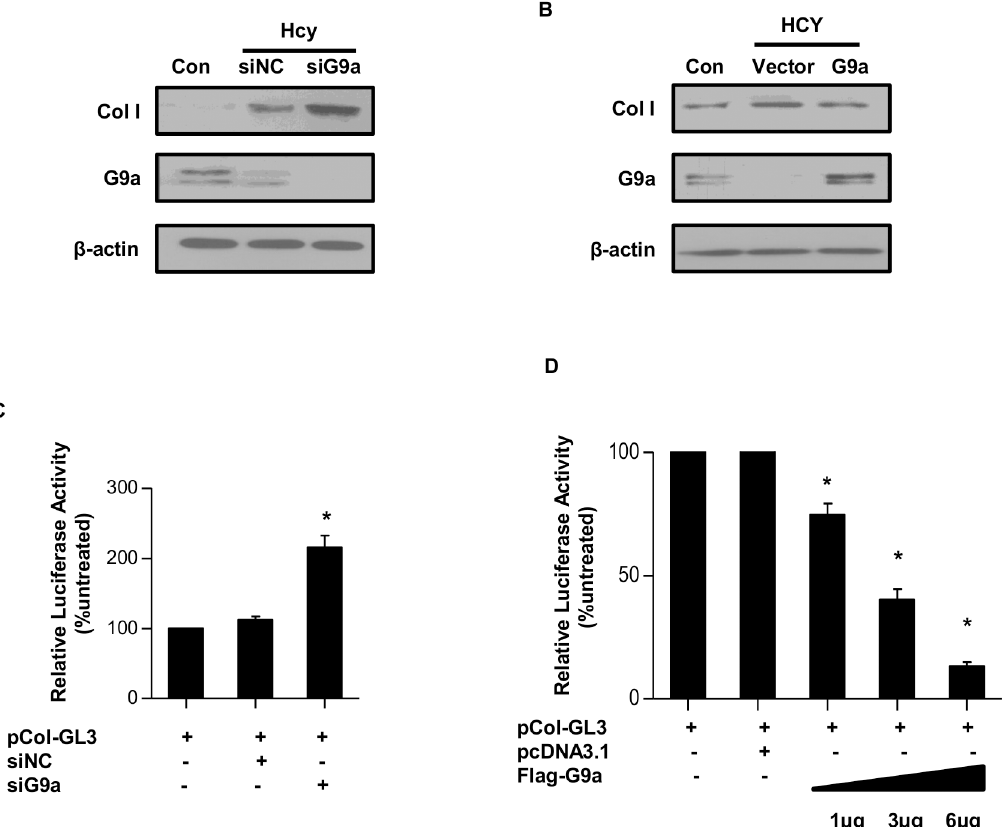
Fig 3. Hcy-induced Col I expression is mediated by G9a. (A) LO2 cells were transfected with scramble siRNA (siNC) or siRNA targeting G9a (siG9a) and then treated with 100 μ M of Hcy for 48 h. Whole cell lysates were harvested, the protein levels of G9a and Col I were determined by Western blotting. β -actin was used to verify equivalent loading. (B) LO2 cells were transfected with Flag-tagged G9a or empty vector, and then treated with 100 μ M of Hcy for 48 h. The protein level of G9a and Col I was determined by Western blotting. β -actin was used to verify equivalent loading. (C) LO2 cells were transfected with either siNC or siG9a together with pCol I-luc plasmid and pRL. Relative luciferase activity was presented. * p < 0.05 versus siNC transfected cells. (D) LO2 cells were transfected with empty vector or indicated amounts of Flag-tagged G9a together with pCol I-luc plasmid and pRL. Relative luciferase activity was presented. * p < 0.05 versus empty vector transfected cells. Data are mean ± SD of three independent experiments.